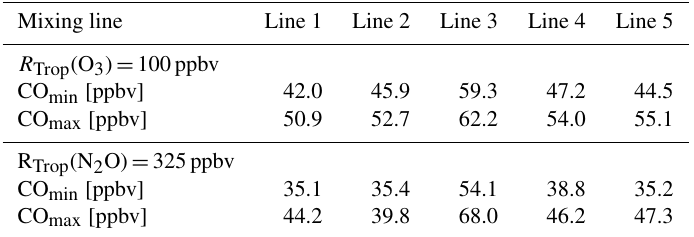
Table 2. Tropospheric “end members” for every mixing line based on the tracer–tracer correlations of O 3 and CO as well as N 2 O and CO (cf. Fig. 4). The values are based on the intercept between the calculated confidence regions with the assumed mixing ratio of O 3 and N 2 O at the tropopause in Fig. 4.